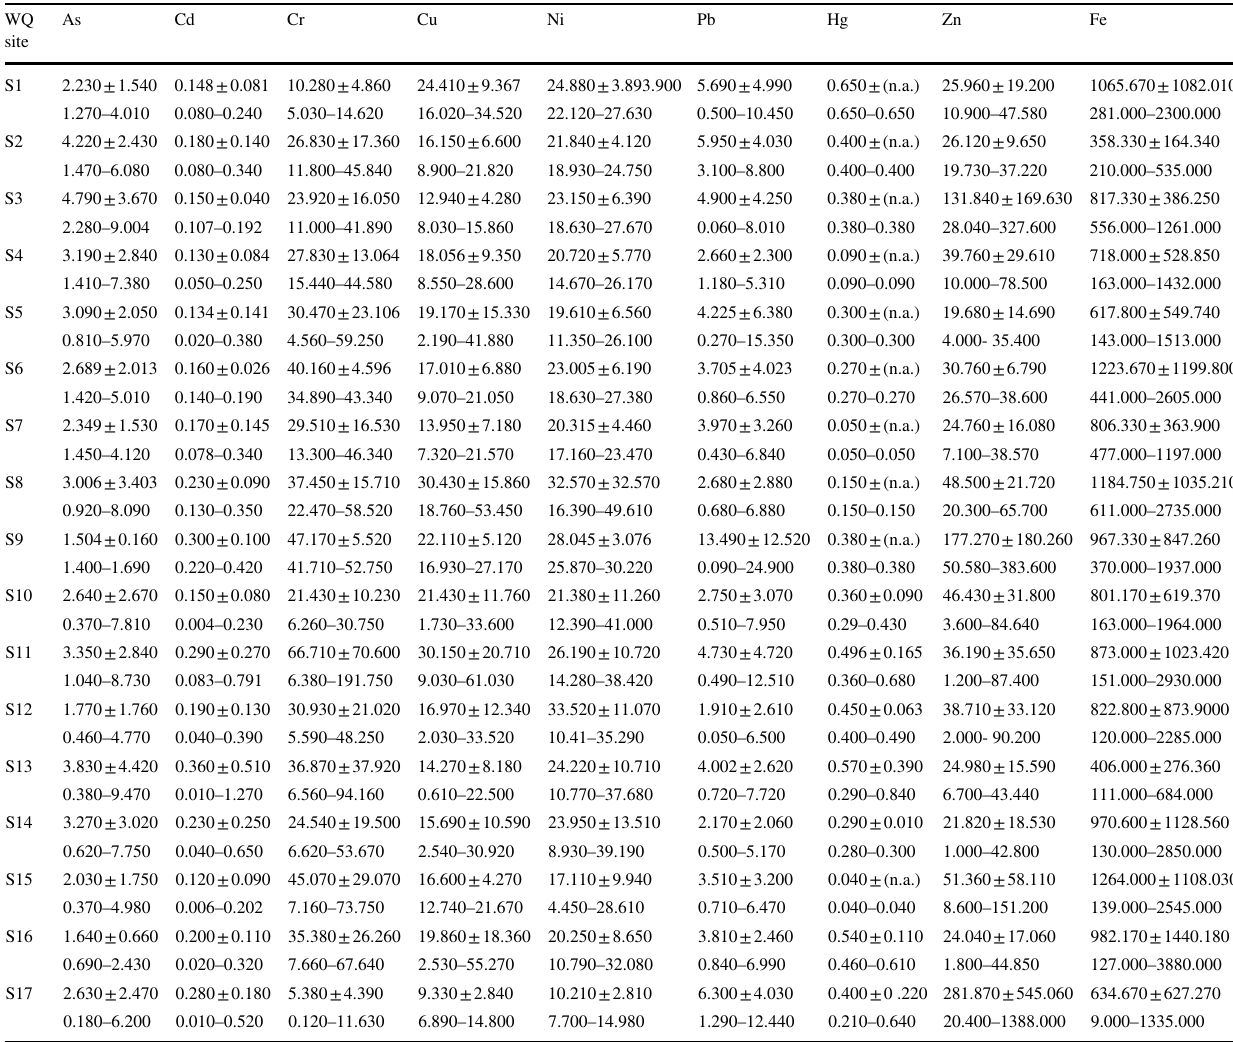
Table 2 Trace and toxic metal concentration (range, average and standard deviation) across different WQ sites (CWC, 2014) WQ